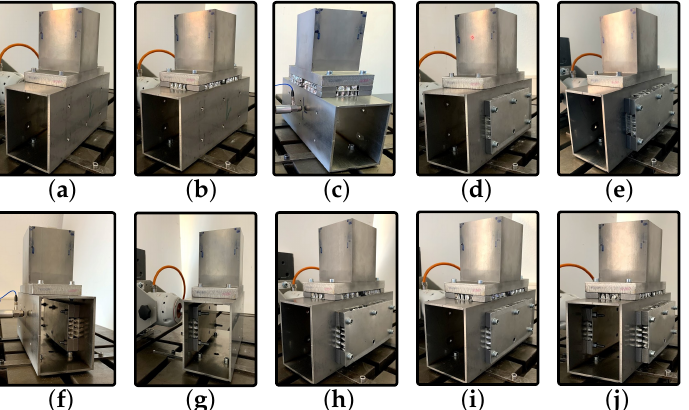
Figure 6. Location of HCDP on the WTS test specimen ( a ) Test specimen without HCDP (Reference test specimen), ( b ) SU HCDP mounted between the sator ring and stator arm ( c ) MU HCDP assembled between the sator ring and stator arm, ( d ) SU HCDP on the outer wall of the stator ring (opposite to excitation point), ( e ) MU HCDP on the outer wall the stator ring (opposite excitation point), ( f ) MU HCDP on the inner wall the stator ring (opposite excitation point), ( g ) SU HCDP on the inner wall of the stator ring (excitation point side), ( h ) Configuration 1, ( i ) Configuration 2, ( j ) Configuration